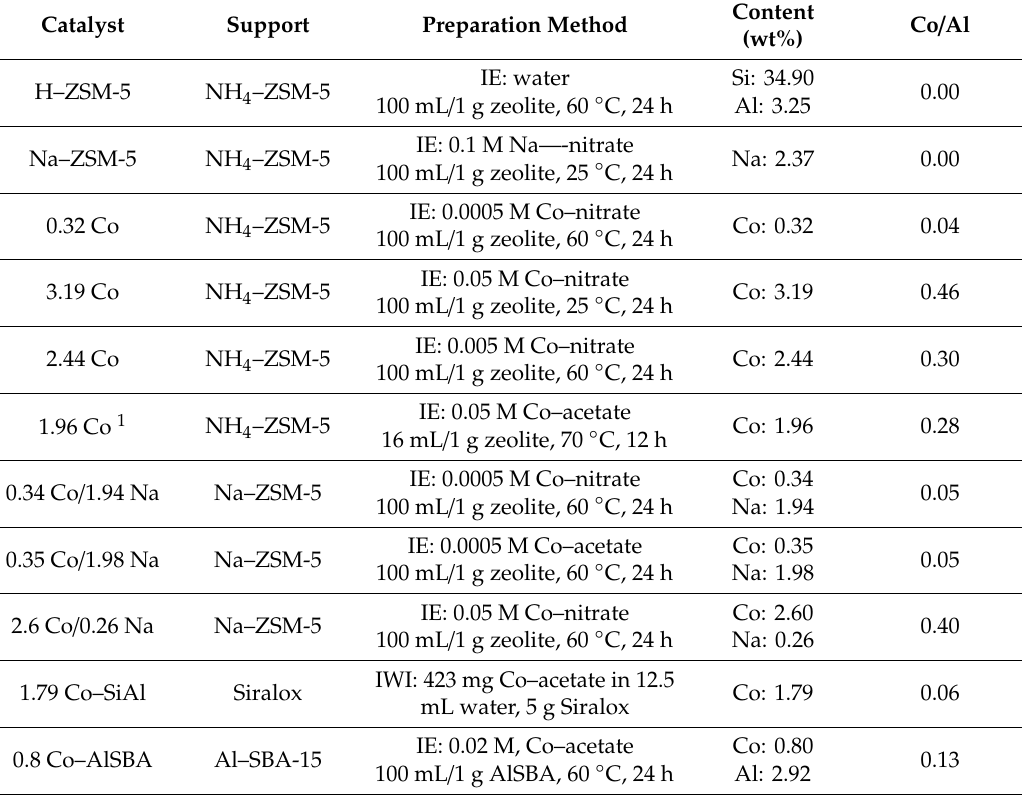
Table 1. Overview of catalysts studied, applied preparation methods, and metal contents. Catalyst Support Preparation